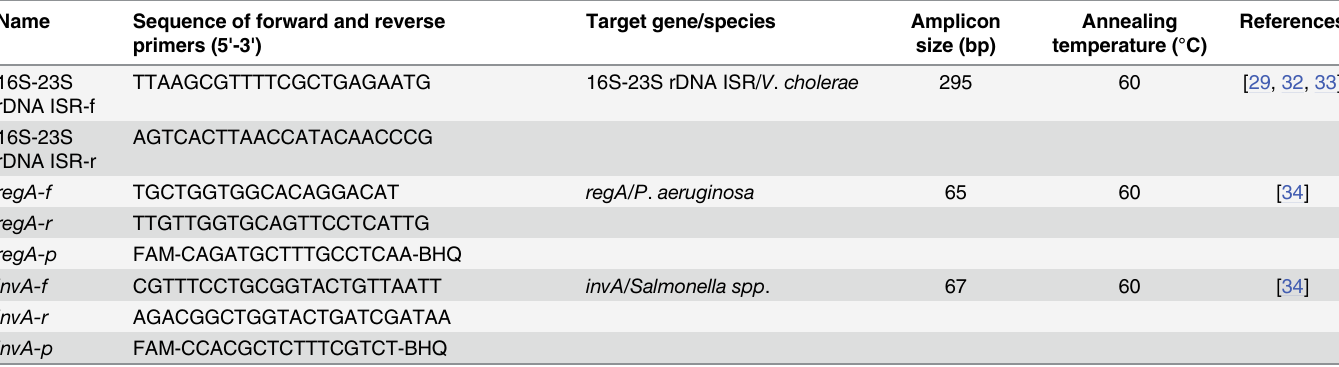
cific for each primer set for 30 s, elongation at 72°C for 30 s, and finally 72°C for 10 min [14]. ARGs were chemically synthesized (AITBiotech, Singapore) and the gene products served as a positive control. For a negative control, the genomic DNA of a susceptible E . coli strain (not containing these ARGs) was used. PCR products were visualized using DNA